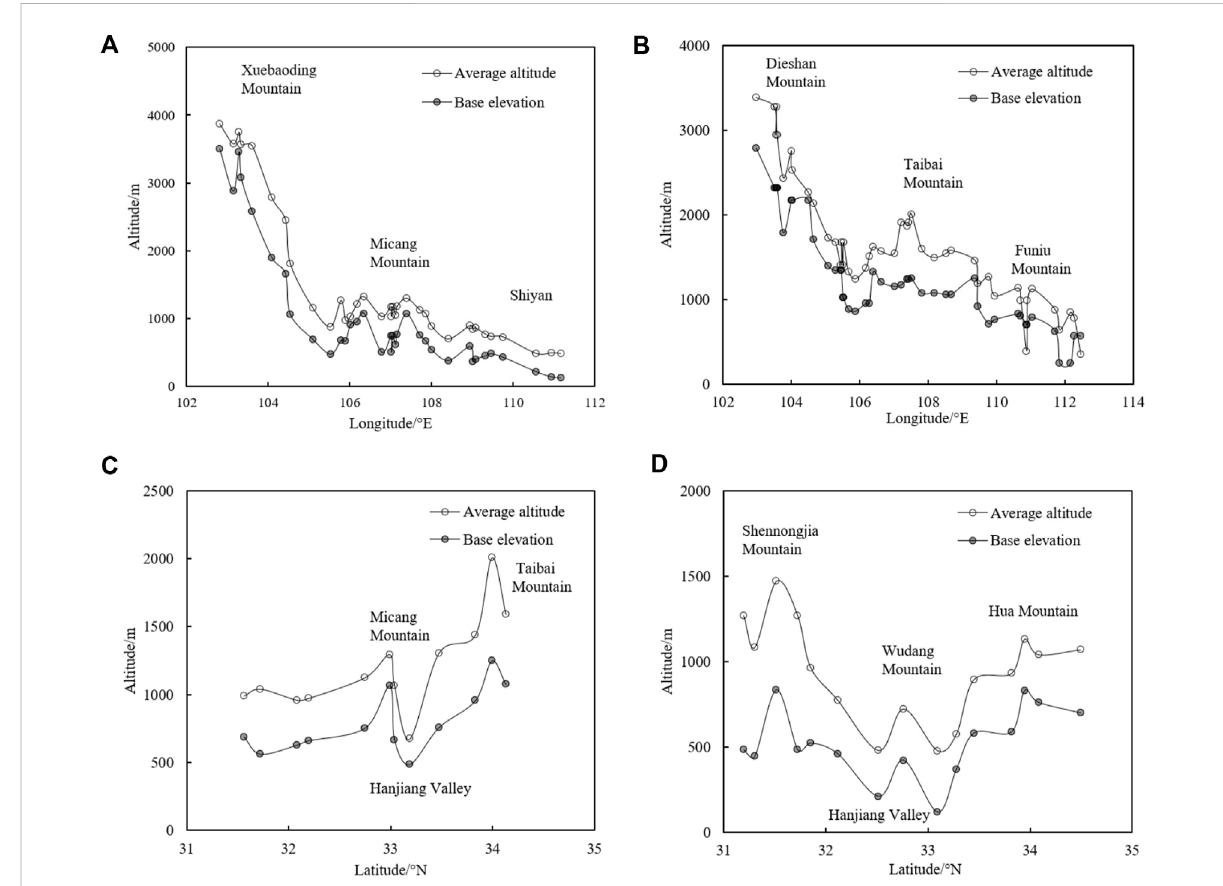
FIGURE 13 Average altitude and mountain base elevation in the QDM along four pro fi les of (A) 32.67 ° N, (B) 33.96 ° N, (C) 107.81 ° E, and (D) 110.53 ° E.